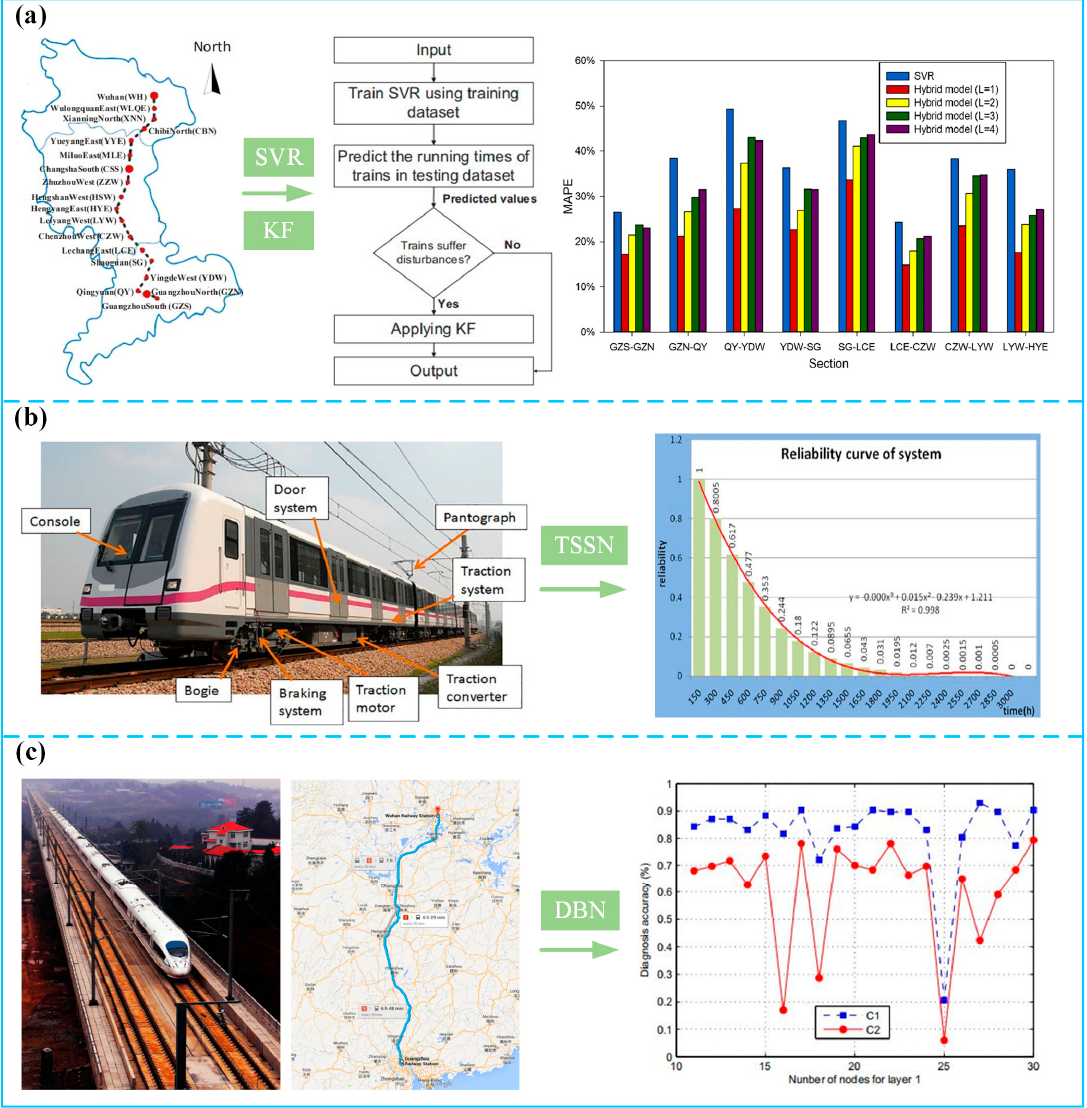
Figure 10. Fault diagnosis method of information control system: ( a ) support vector regression (SVR) and Kalman filter (KF) [97]; ( b ) train safety sensor network (TSSN) [96]; ( c ) deep belief network (DBN) [98].